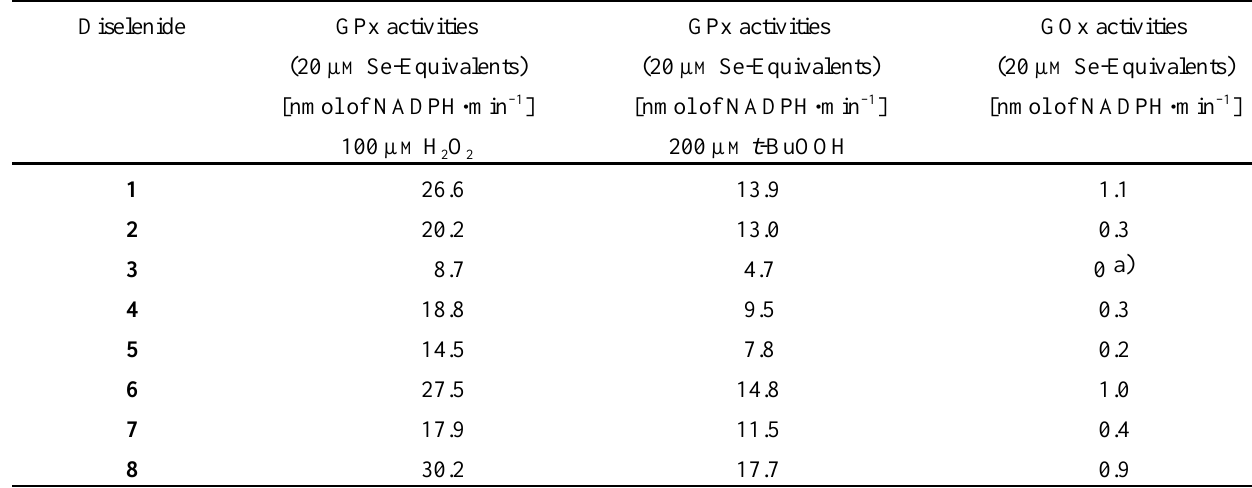
Table 1 . GPx and GOx activities of diselenides 1 –